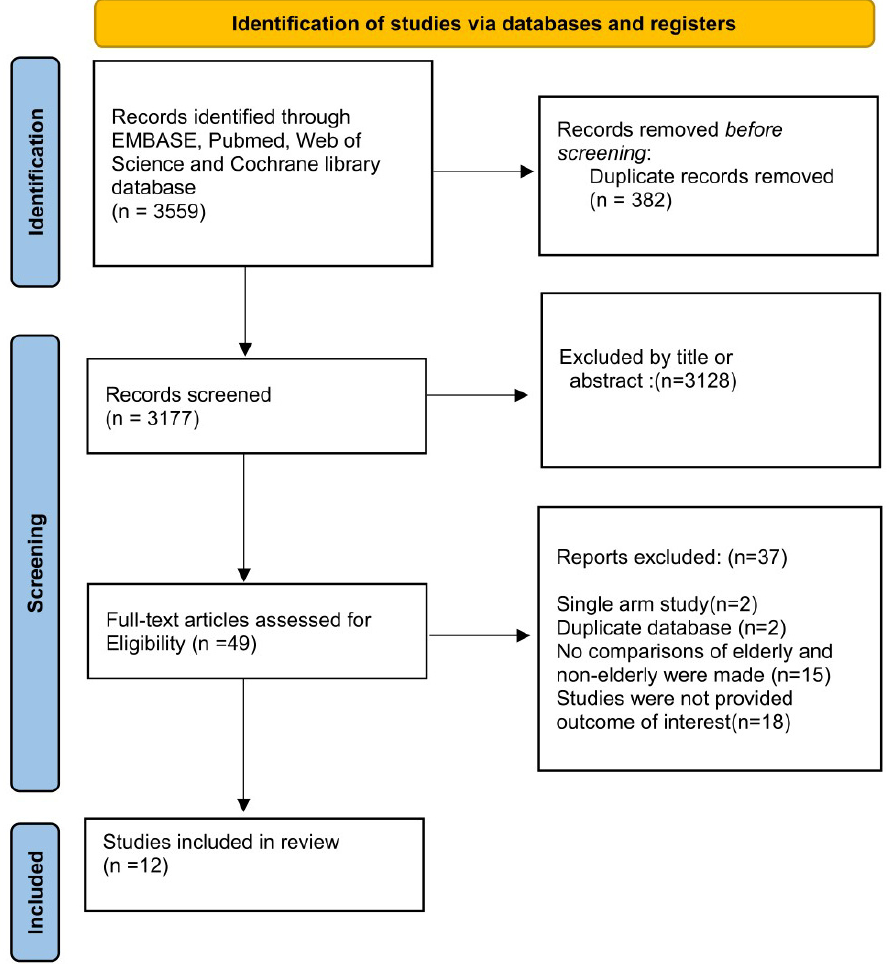
Figure 1. Summary of electronic search and included/excluded studies.